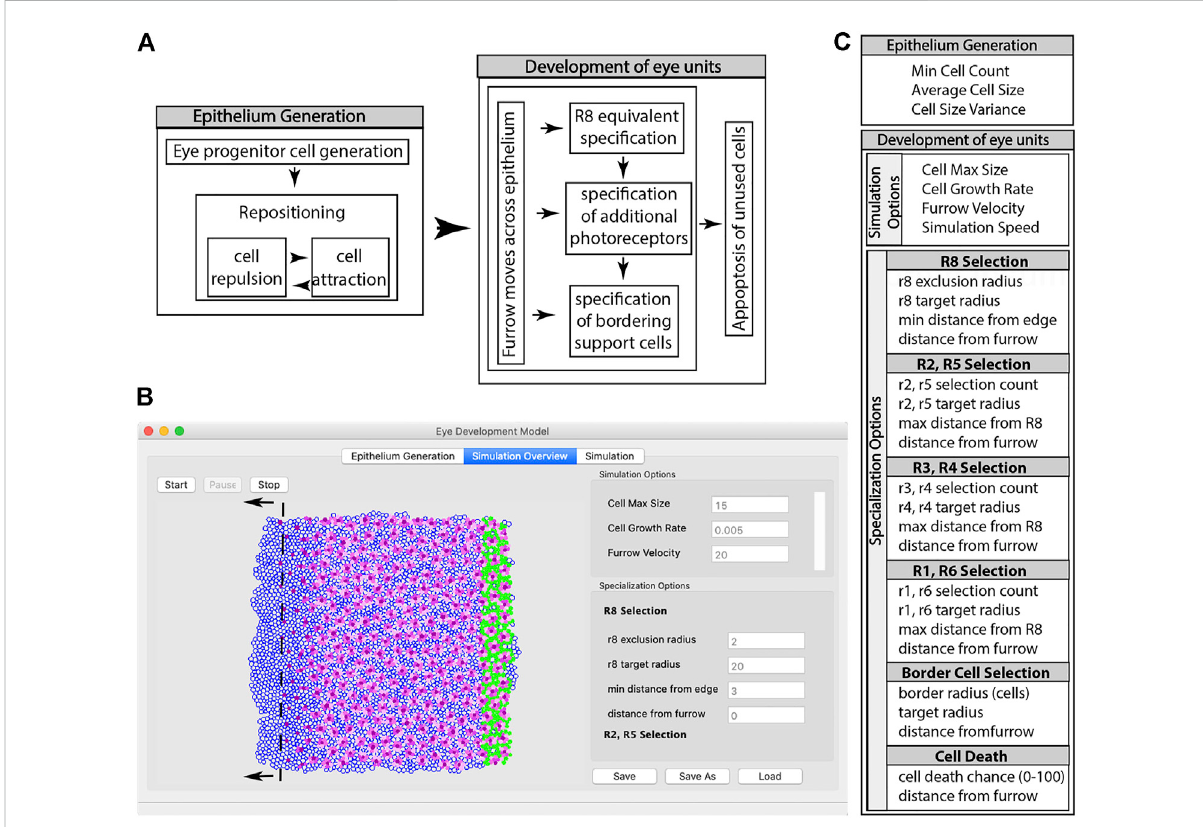
FIGURE 1 Summary of the steps involved in a simulation using EyeVolve. (A) . The fi rst set of steps involves the generation of the precursor epithelium. In the simulation, a user-set pool of eye progenitor cells is generated and repositioned to form a tissue consisting of a single layer of cells. Once the epithelium is generated, the eye unit simulation proceeds, which is initiated by the speci fi cation of the R8 founder cell, followed by additional photoreceptorandbordercells. (B) .Asillustratedbyasnapshotoftheprograminterface,themodelassumesavirtualgradient(dashedline)that moves from right to left and sets the timing for the speci fi cation of R8-like cells, additional photoreceptors, and ultimately border cells. The simulationinterfaceisdividedintotheEpitheliumGenerationwindow(lefttab), whichallowstheusertoenterparametersforepitheliumgeneration, the Simulation Overview window (middle tab), which allows the user to enter parameters for the development of eye units, and the Simulation window (right tab), which allows the simulation to be viewed. (C) . List of modi fi able input